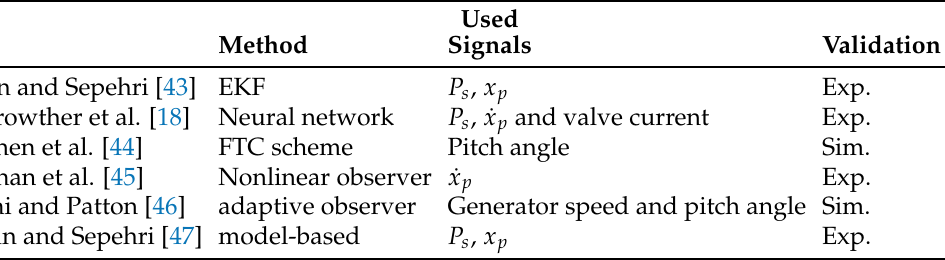
Table 7. Covered fault detection methods for supply faults. The notations of the used signals can be found in Figure